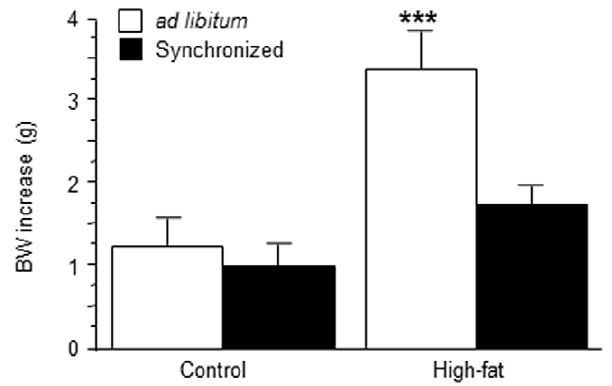
Figure 1. Effect of forced synchronization of feeding on body weight gain. Four-week old mice had access either to control or to high-fat diet during four weeks. After this period, animals were submitted to a forced synchronization protocol during four supple- mentary weeks. At the end point, body weight increase during the last four weeks was higher in high-fat ad libitum animals than in the other three groups. ***p , 0.001, compared to the other groups (Newman- Keuls’ test).